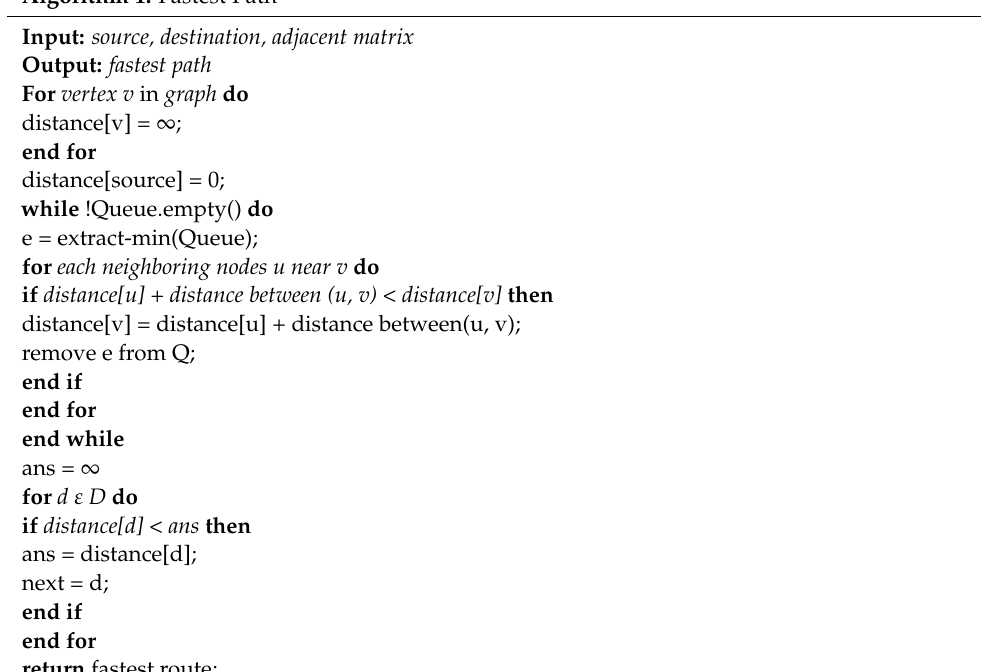
Algorithm 1: Fastest